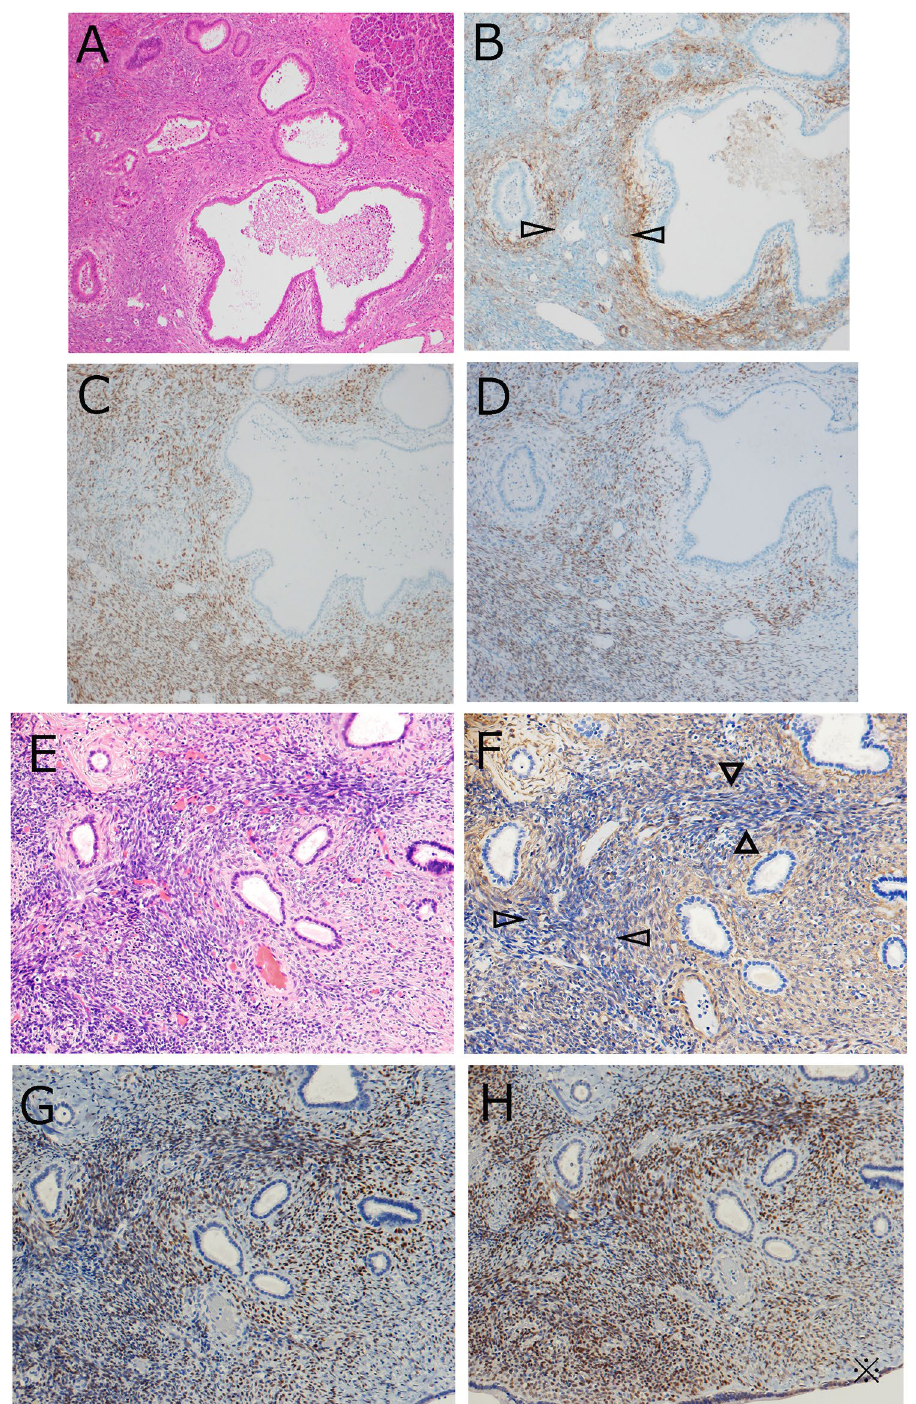
Figure 2. Occasional α smooth muscle actin (SMA)-negative status of ovarian-like stroma (OLS). ( A – D ) Mucinous cystic neoplasm (MCN) case 1. ( A ) OLS in the intralobular portion. ( B ) The OLS at the periductal part is α-SMA-positive and that with no association to dilated ducts is α-SMA -negative. C and D. The OLS is positive for ER ( C ) and PgR ( D ), irrespective of the distance from the ducts. 2E-H. MCN case 10. ( E ) OLS at the septum of the MCN cyst. ( F ) The OLS at the periductal part is α-SMA-positive and that with no association to dilated ducts is α-SMA -negative. ( G , H ) OLS is positive for ER ( G ) and PgR ( H ), irrespective of the distance from the ducts. Blank arrowheads in B and F show areas of α-SMA-negative OLS. ( B , F ) Immunohistochemistry for α-SMA, ( C , G ) Immunohistochemistry for ER, and ( D , H ) Immunohistochemistry for